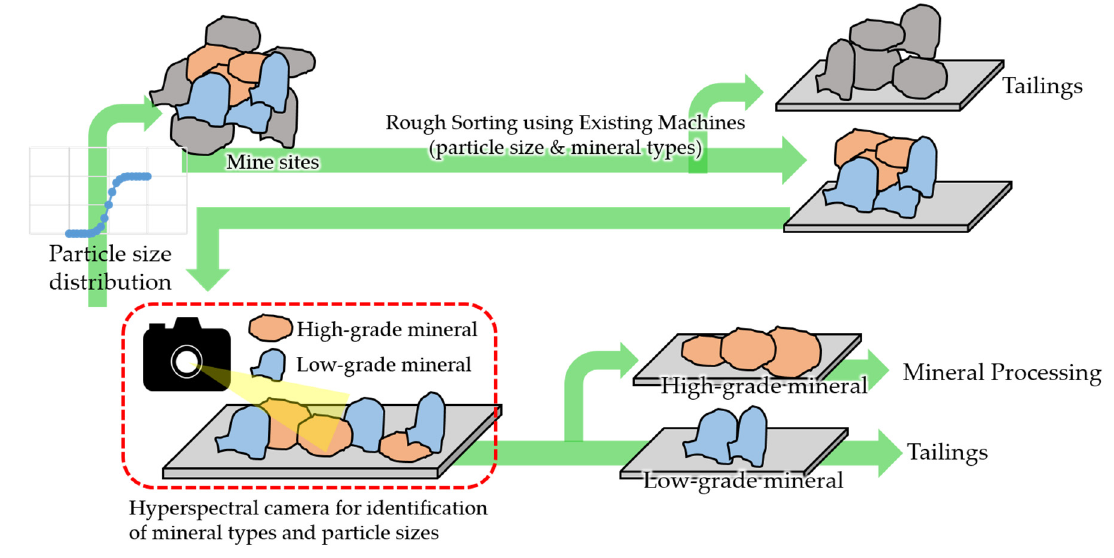
Figure 1. Schematic diagram of mineral processing using hyperspectral imaging and deep learning